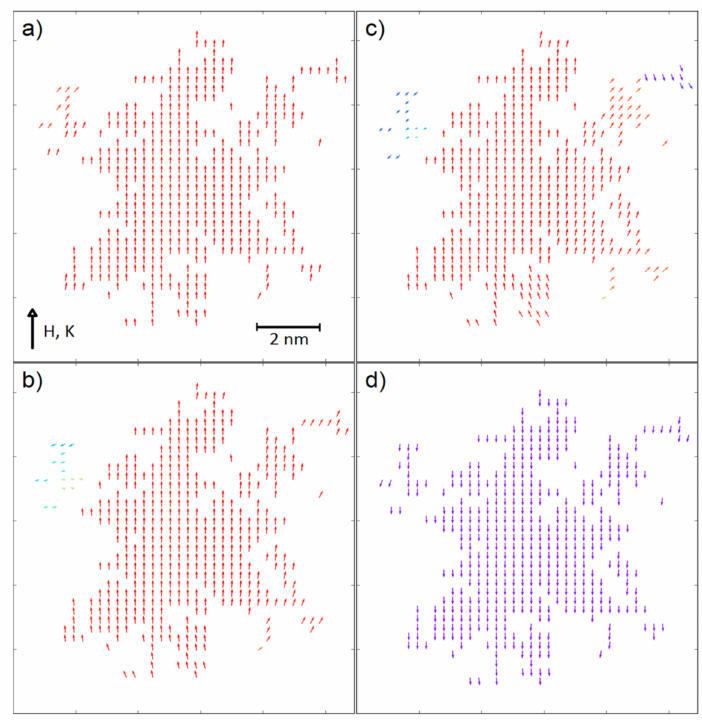
Figure 4. Spin configurations (cross-section) of the system with K S = 5 × 10 − 4 eV, K V = 5 × 10 − 4 eV, n = 1, S = 1 and N S /( N S + N V ) = 0.7 in the external magnetic field equal to ( a ) 0 T, ( b ) − 1.6 T, ( c ) − 2 T and ( d ) − 2.2